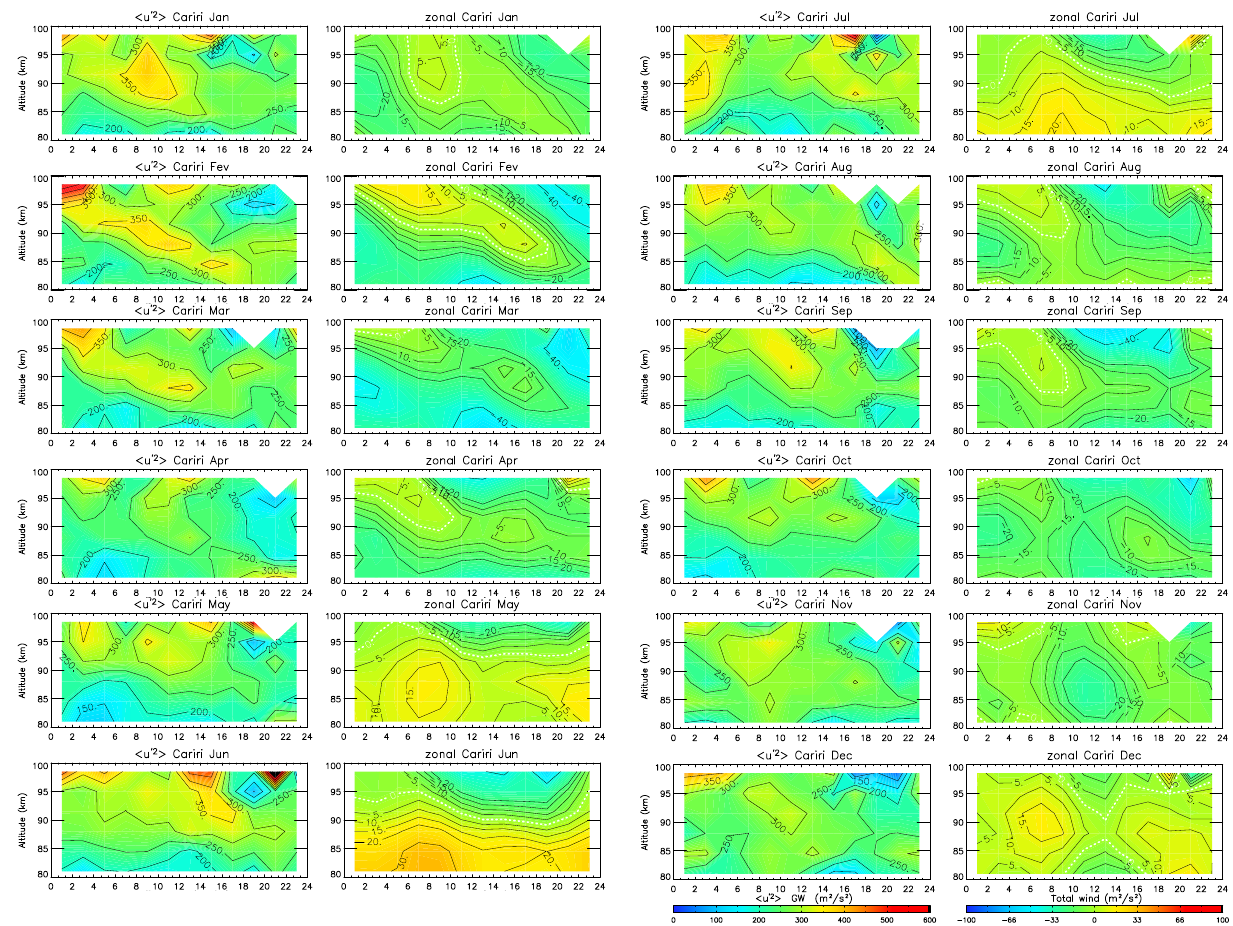
Fig. 5. Zonal component of variances (left side) and the total wind (right side) averaged from 2005 to 2008 over São João do Cariri. All panels show the height/time variation of their respective variable. The altitude is measured in km, and the x axis represents Universal Time (UT) beginning at midnight, and each line of the variances contour plot corresponds to 50m 2 s − 2 . The total wind is measured in ms − 1 and the white dashed line indicates where the values are